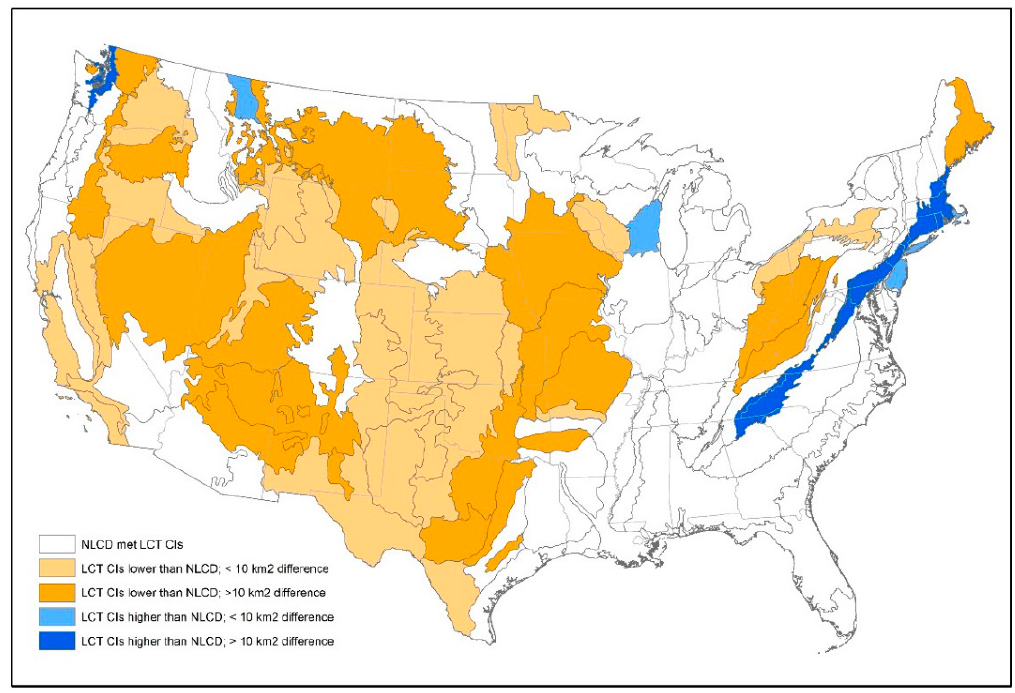
Figure 2. A comparison of forest to developed land cover area change between LC Trends (LCT) confidence intervals (CIs) estimates and the 1992 Retrofit NLCD- NLCD 2001 for the 1992–2000/2001 time interval.